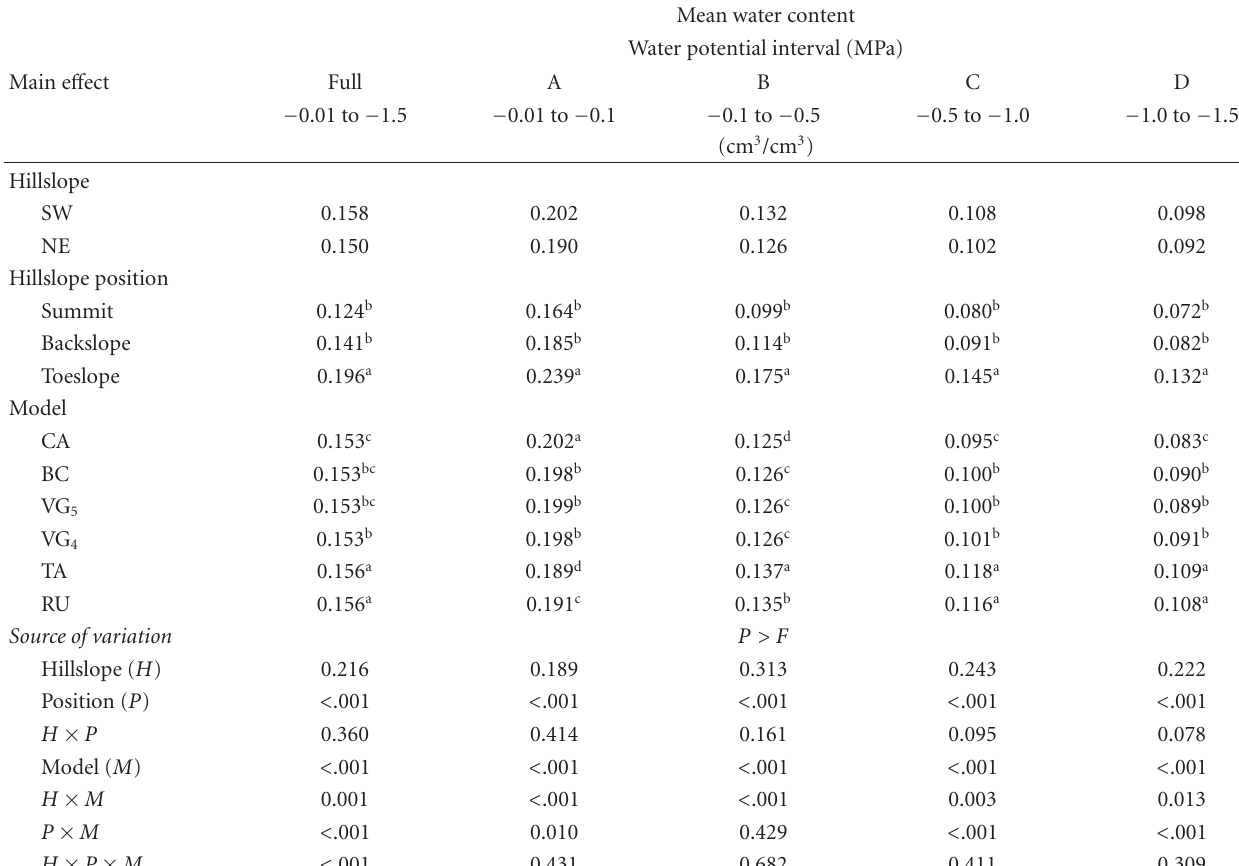
Table 5: Mean water content for water potential intervals based on weed seed germination sensitivity to water